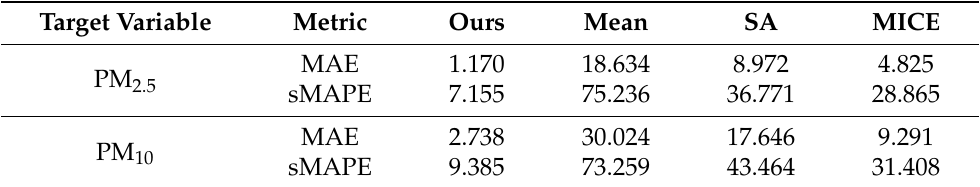
Table 2. Imputation performances of the proposed method and of other imputation methods on the Guro-gu dataset. Our results show the performance of the proposed method, which achieves the best imputation accuracy.